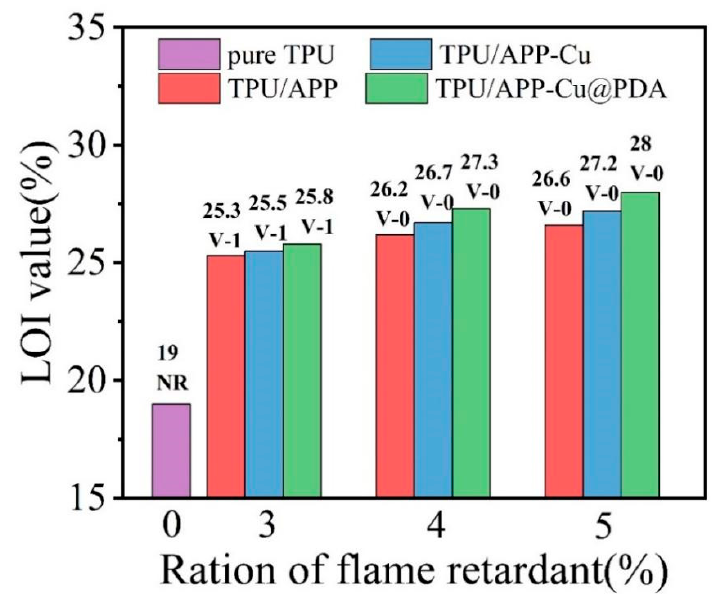
Figure 5. LOI and UL-94 results for TPU and TPU composites.